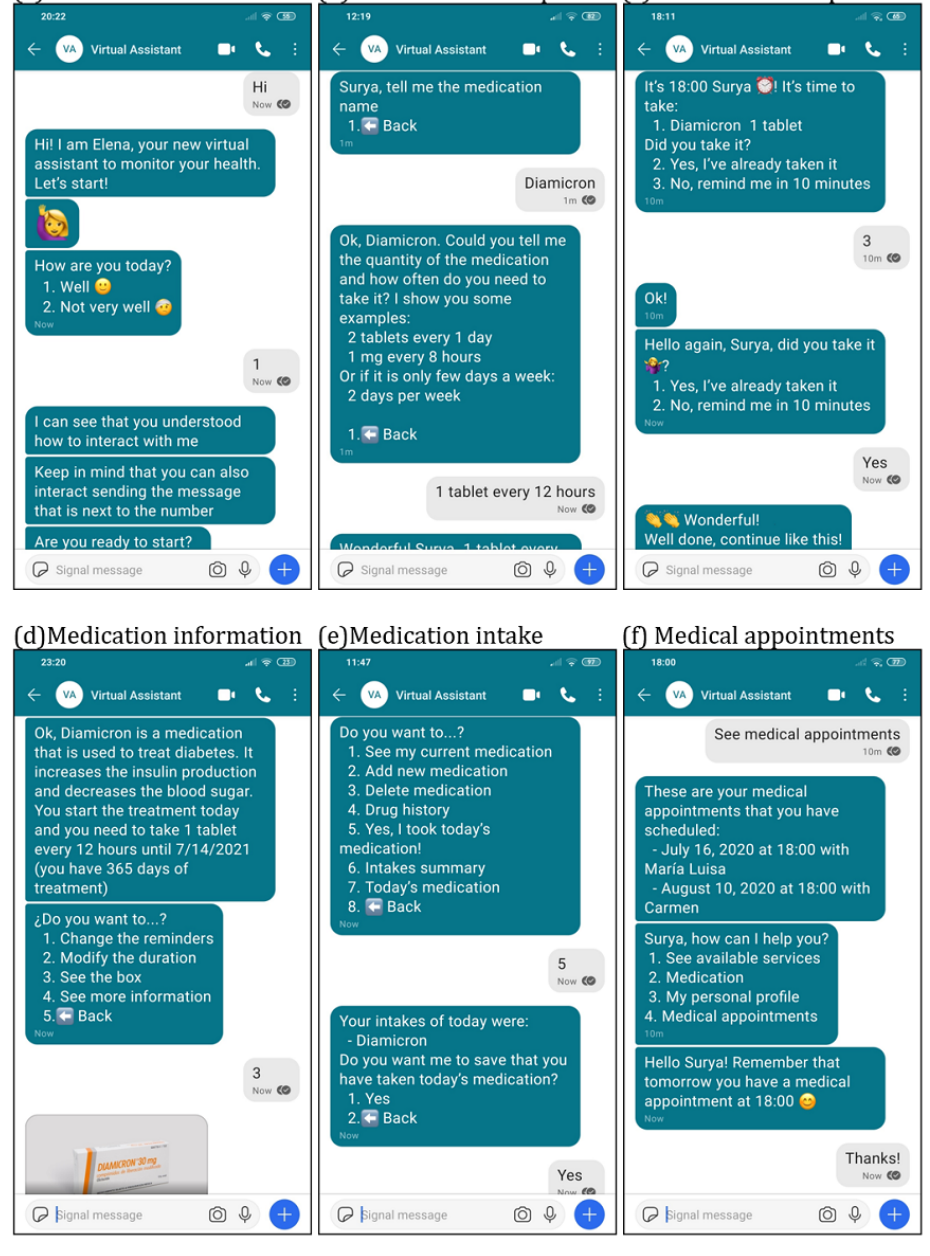
Figure 1. Screenshot of real interactions with the virtual